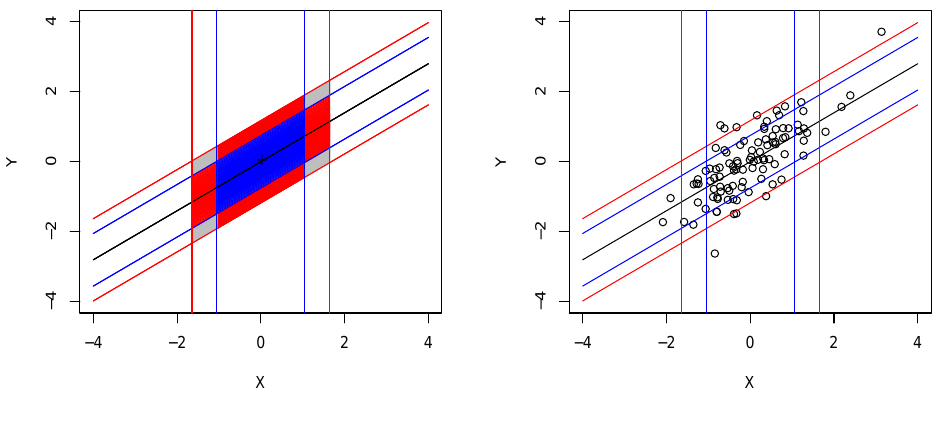
Figure 2: BBP in option 2 (left) for the normal model considered in Example 2.1. The blue region contains the 50% of the data, the four red regions the 27.27922% and the four grey regions the 3.720779% . In the right plot we add 100 simulated data from this